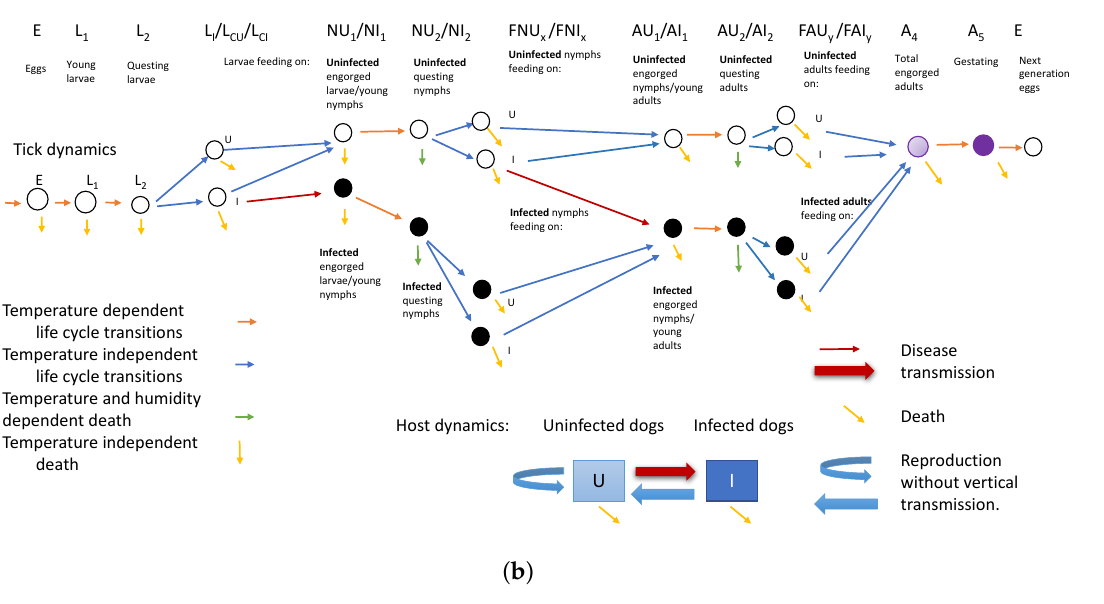
Figure 1. ( a ) A diagram of the overall study plan for communities A and B. ( b ) Compartment model for accompanying process-based model. Orange and green arrows indicate temperature or temperature and humidity dependent transitions. Black compartments are infective